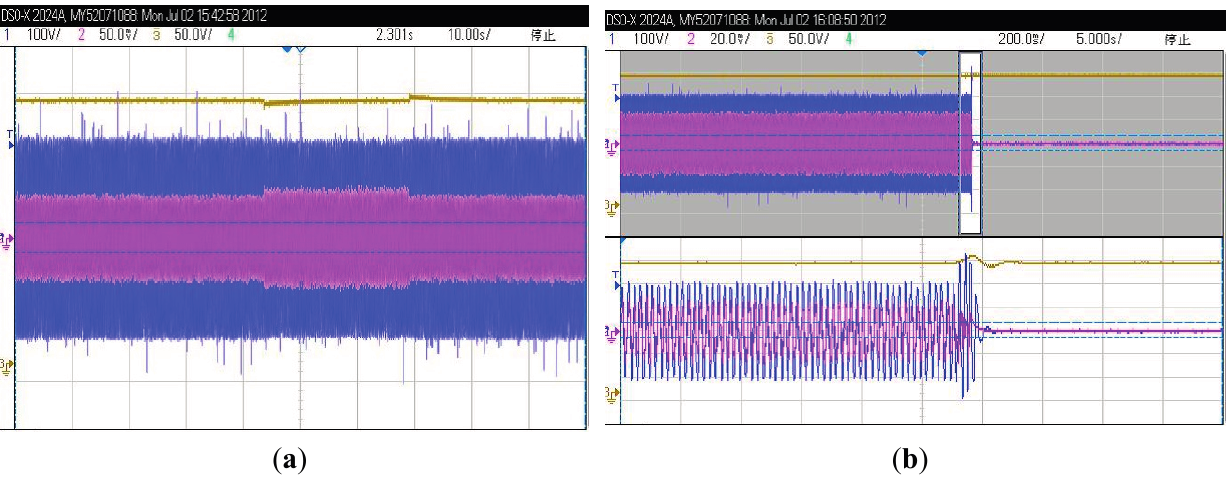
Figure 7. ( a ) Waveform of the converter switching from grid-connected mode to rectifier mode; ( b ) Waveform of the converter switching from grid-connected mode to islanded operation